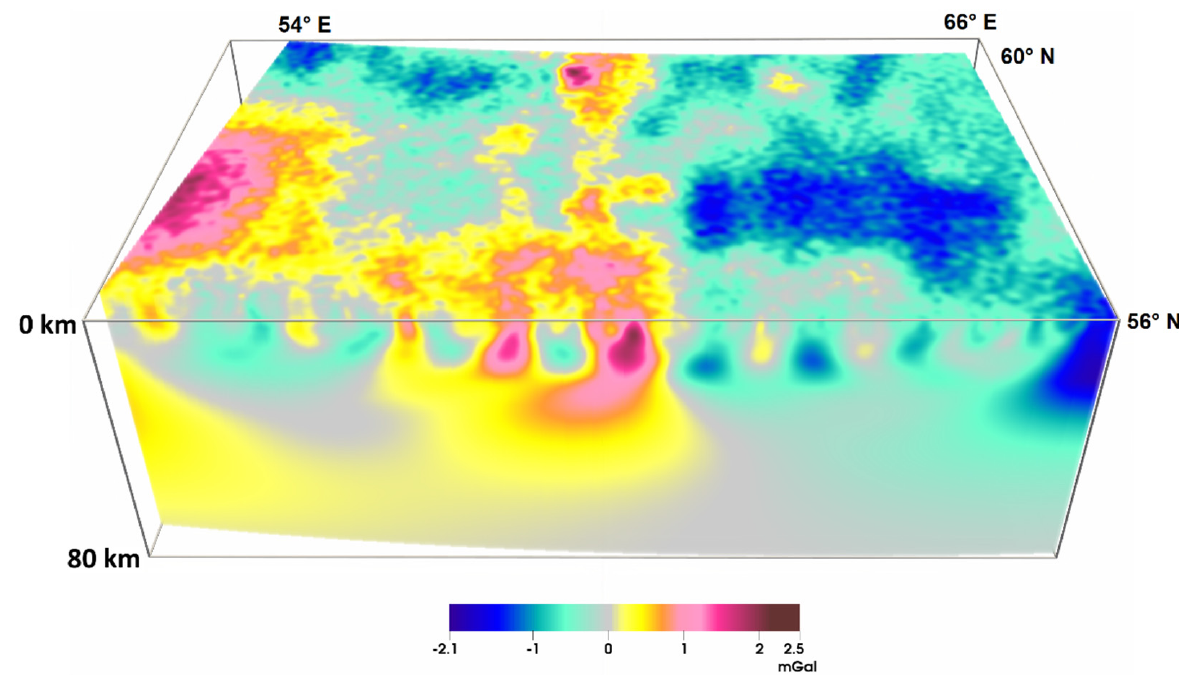
Figure 14. “Cuboid of the separated fields”. The layers are 1 km thick.